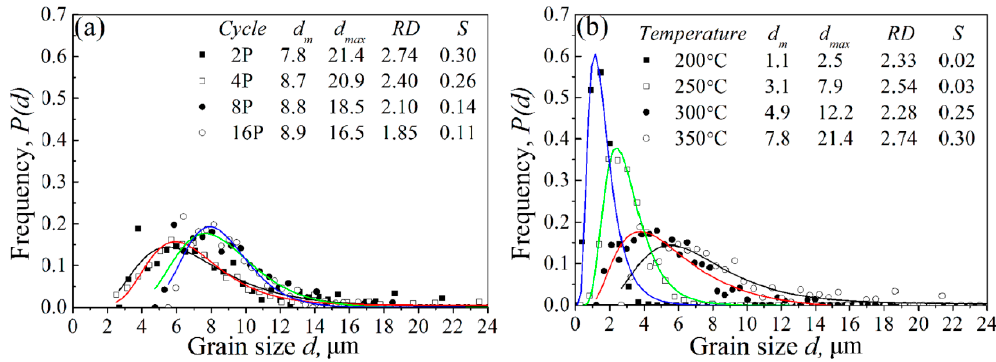
Figure 5. Grain size distribution of CECed ZK61 alloy rods at ( a ) 350 °C and ( b ) 2P.